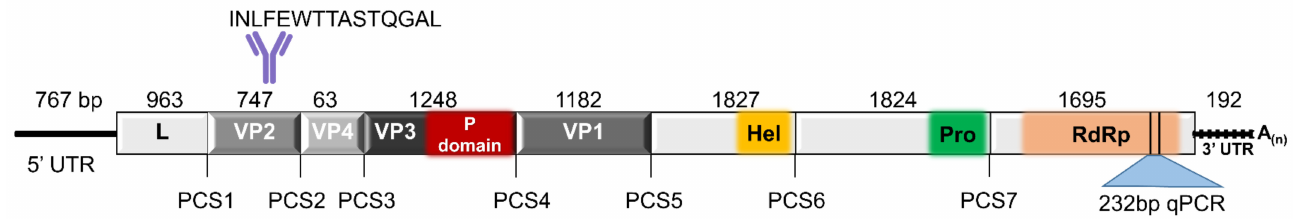
Figure 1. T. castaneum Iflavirus genome annotation based on the full amino acid sequence aligned with DWV: Deformed Wing Virus [30]; SBPV: Slow Bee Paralysis Virus [35] and DsLJV: Drosophila suzukii La Jolla Virus [19]. UTR: untranslated region; L: leader protein; VP2, 4, 3 and 1: viral capsid proteins 2, 4, 3 and 1; Hel: helicase; Pro: 3C-protease; RdRp : RNA dependent RNA polymerase; PCS: protease cleavage